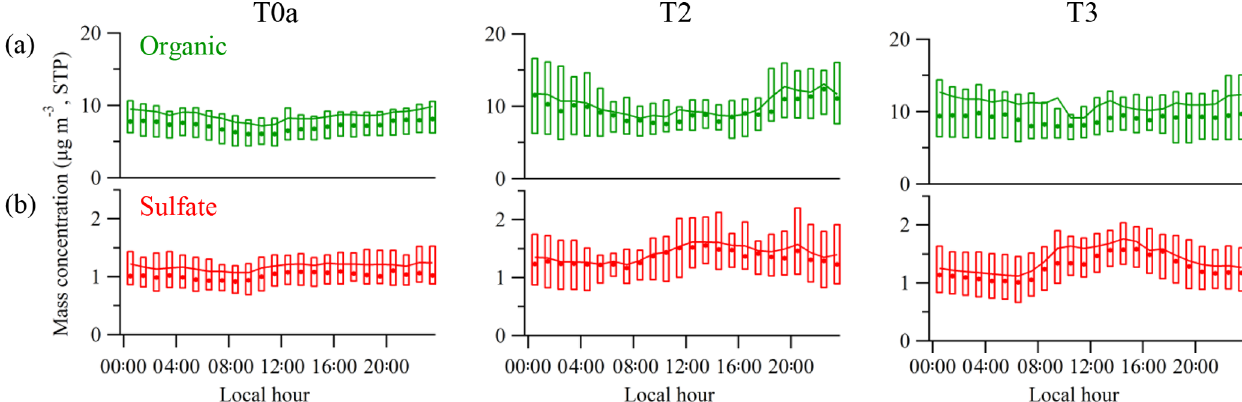
Figure 4. Diel trends of (a) organic and (b) sulfate mass concentrations at the T0a, T2, and T3 sites. Lines represent means, solid markers show medians, and boxes span interquartile ranges. Local time is UTC minus 4h. Concentrations were adjusted to standard temperature (273.15K) and pressure (10 5